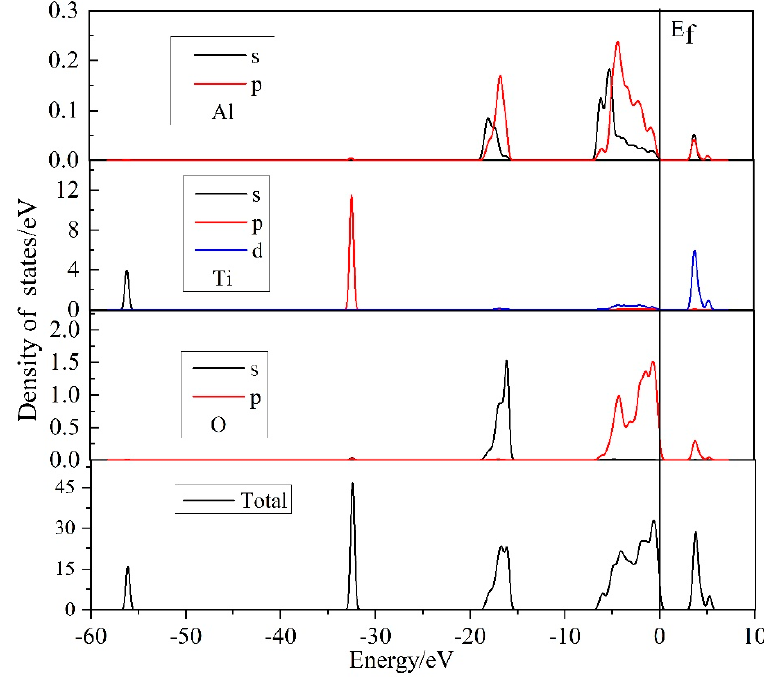
Figure 5. Total and partial DOS of the Al 2 TiO 5 crystal.